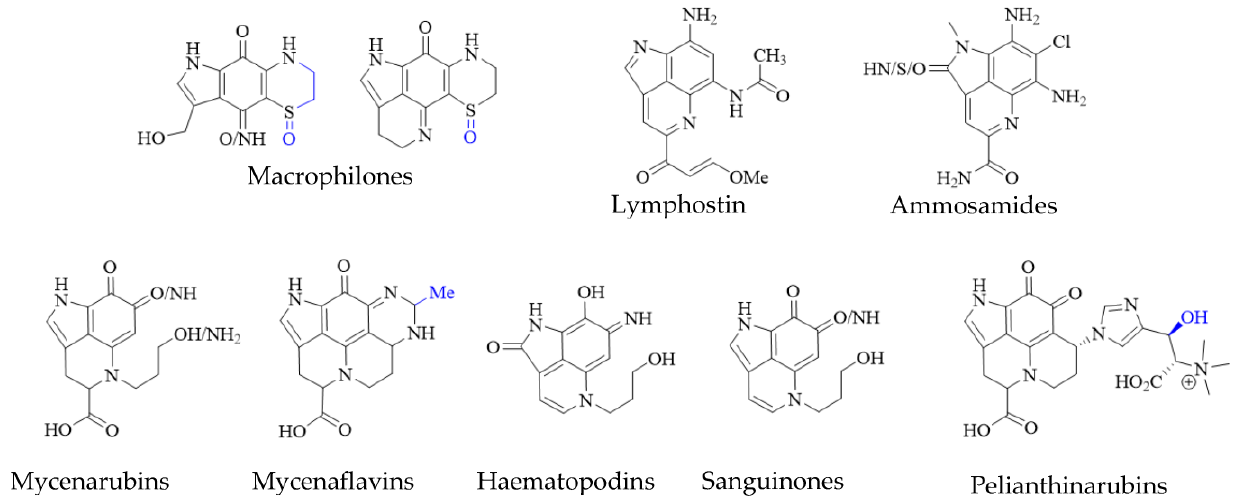
Figure 5. Pyrroloiminoquinone-related natural products from marine hydroids, marine soil-derived bacteria, and terrestrial fungi. Variable substituents are shown in blue.